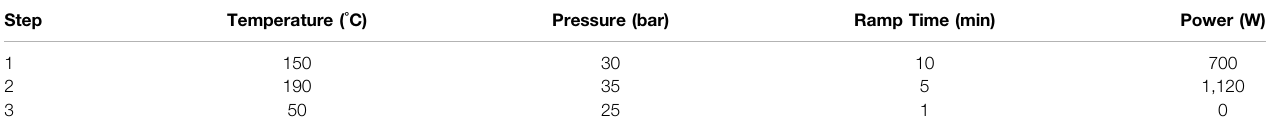
TABLE 1 | Program for digestion of herbal medicines used to microwave digestion equipment. Step